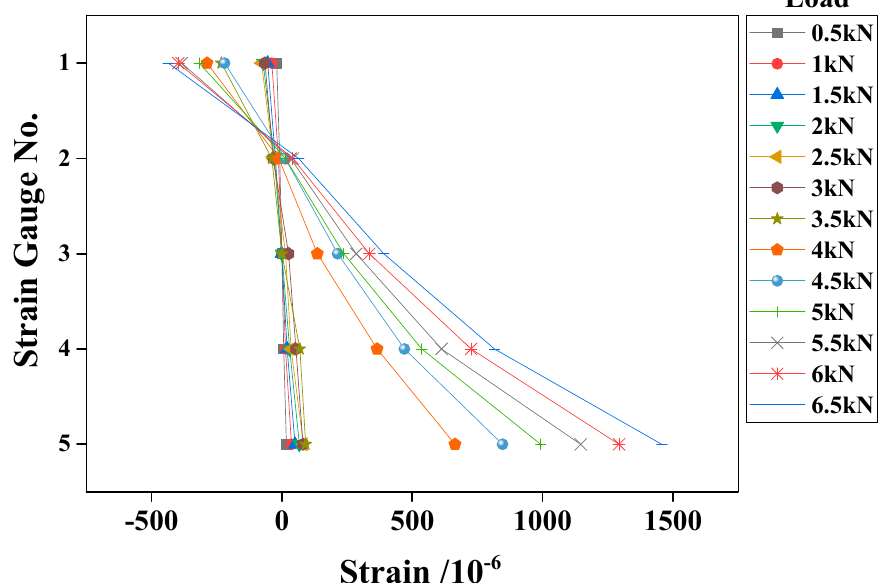
Figure 5. Plane cross-section assumption of the experimental beam.